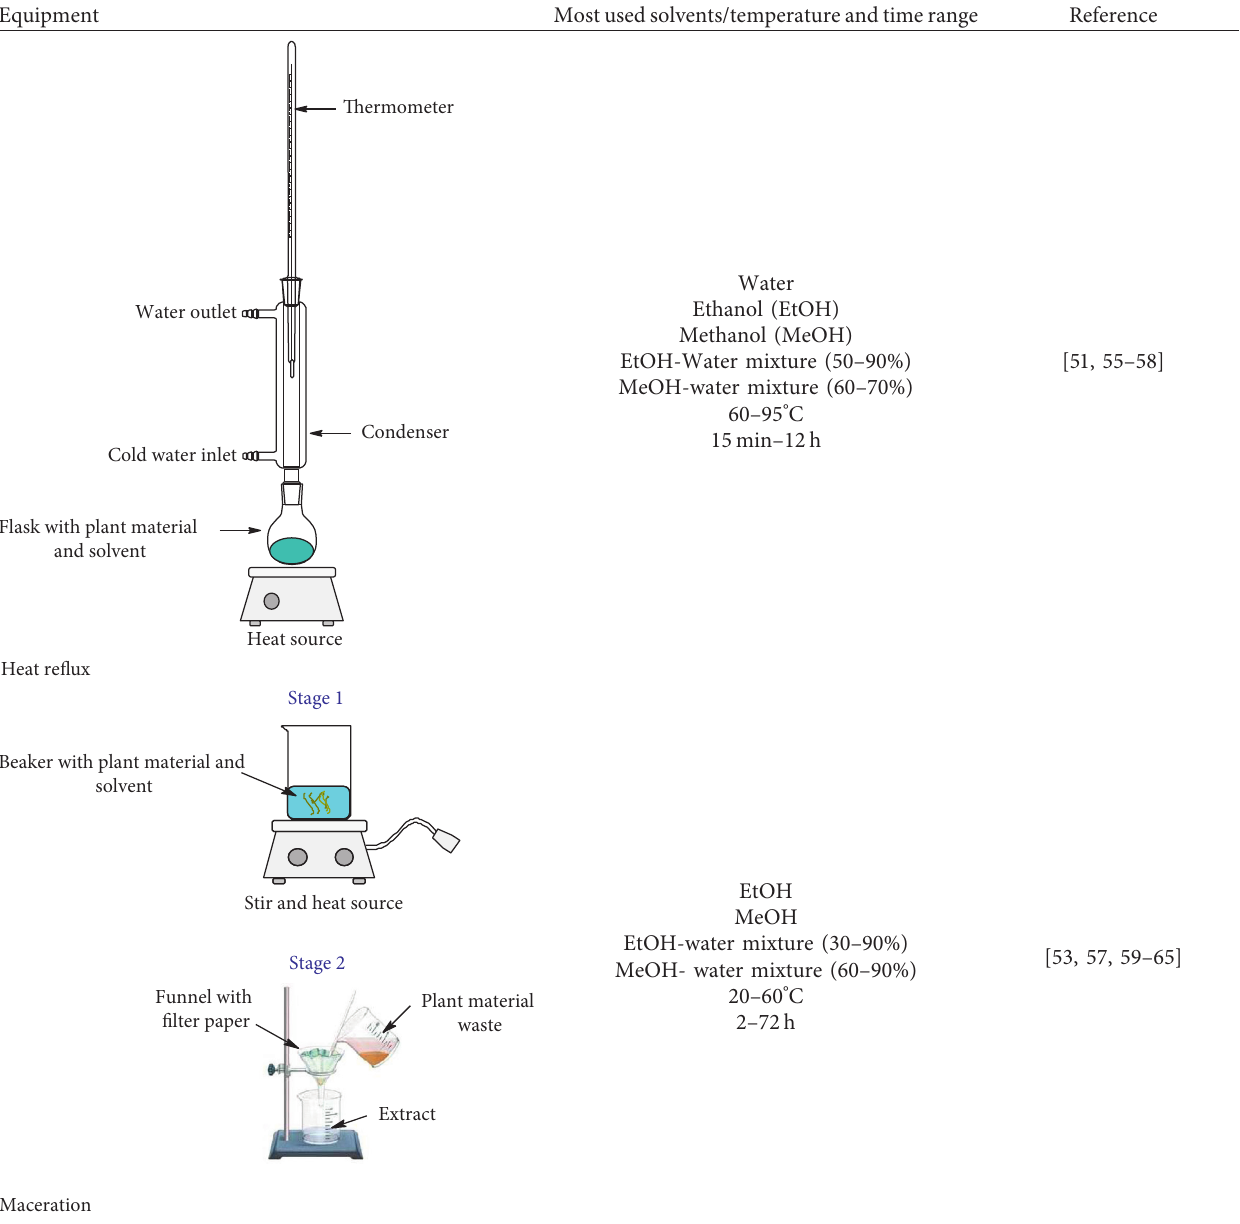
Table 1: Representation of the most common extraction conditions and equipment used in the different conventional methods.